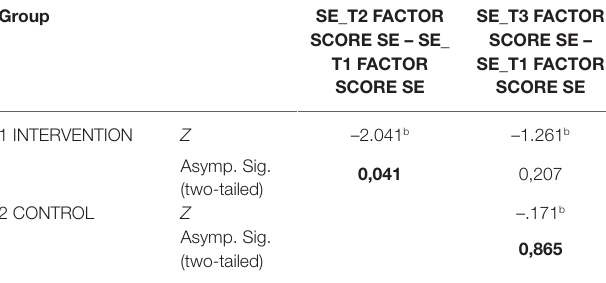
TABLE 9 | Intervention and control test